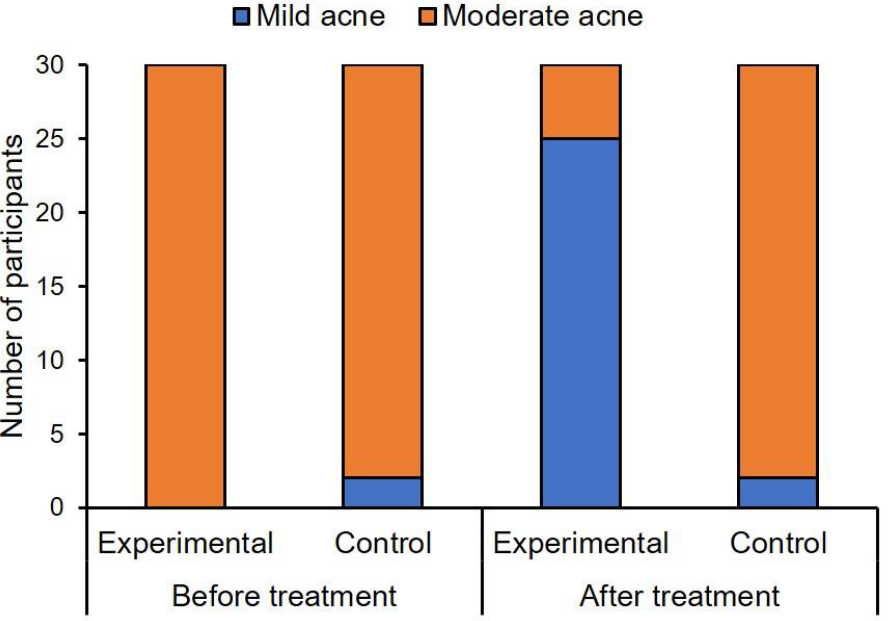
Figure 2. Differences in acne severity between the experimental and control groups, before and after